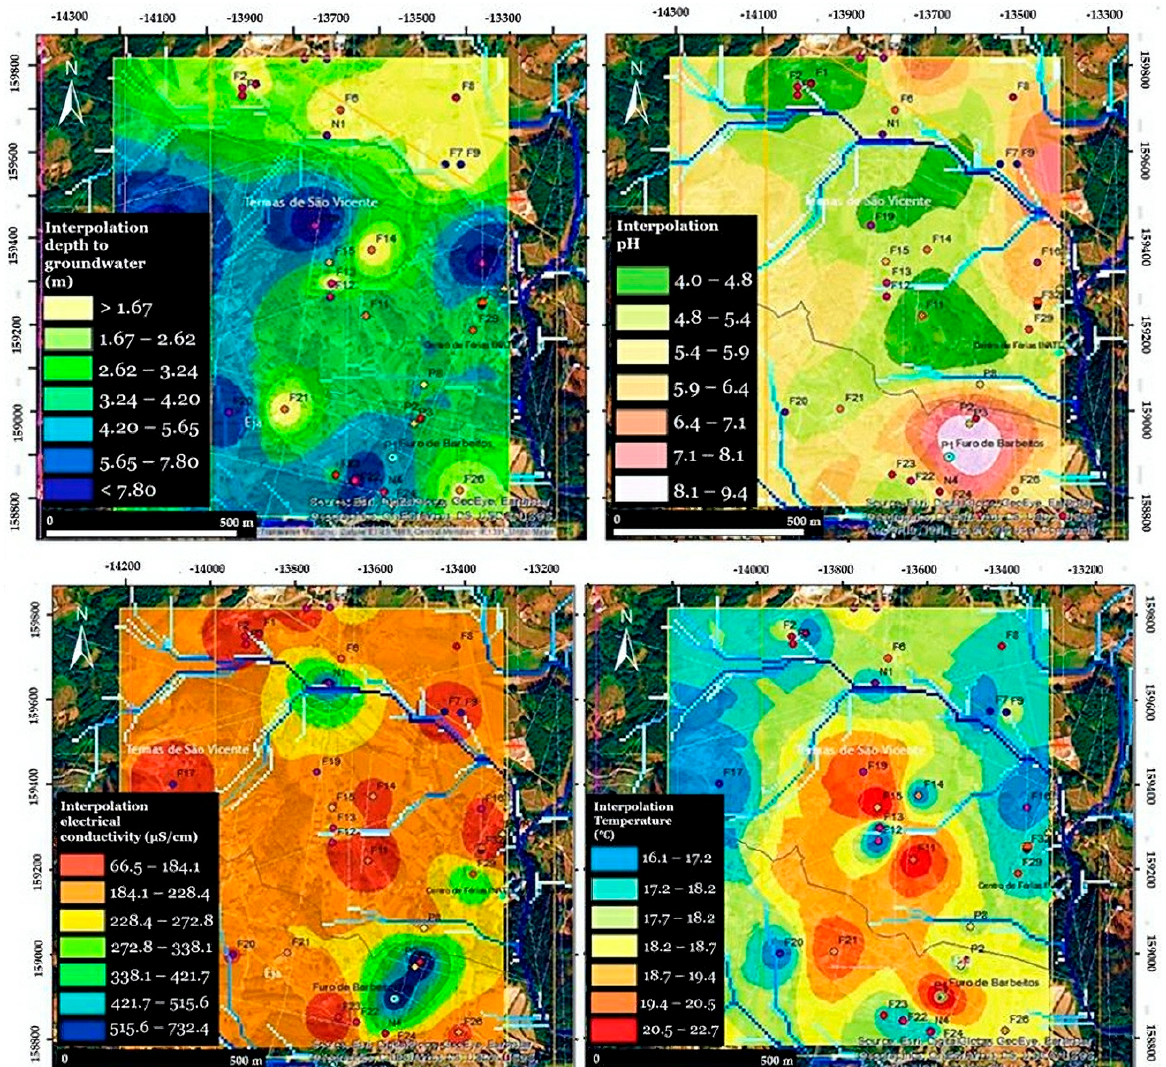
Figure 9. Electrical conductivity, pH, temperature, and surface piezometric level interpolation map of the area surrounding the ‘Barbeitos’ borehole.